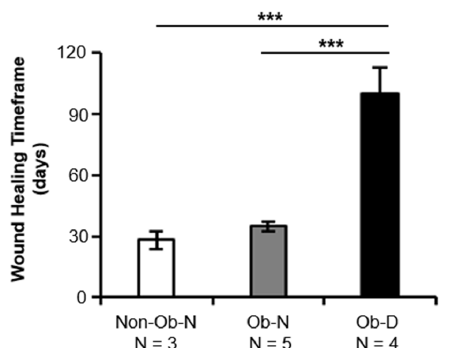
Figure 1. Wound healing timeframes for non-obese patients with a normal wound healing rate (Non-Ob–N; n = 3), obese patients with a normal wound healing rate (Ob–N; n = 5), and obese patients with delayed wound healing (Ob–D; n = 4). The clinical timeframe for normal wound healing was defined as 20–45 days, and for delayed wound healing, 90+ days. *** p < 0.001.